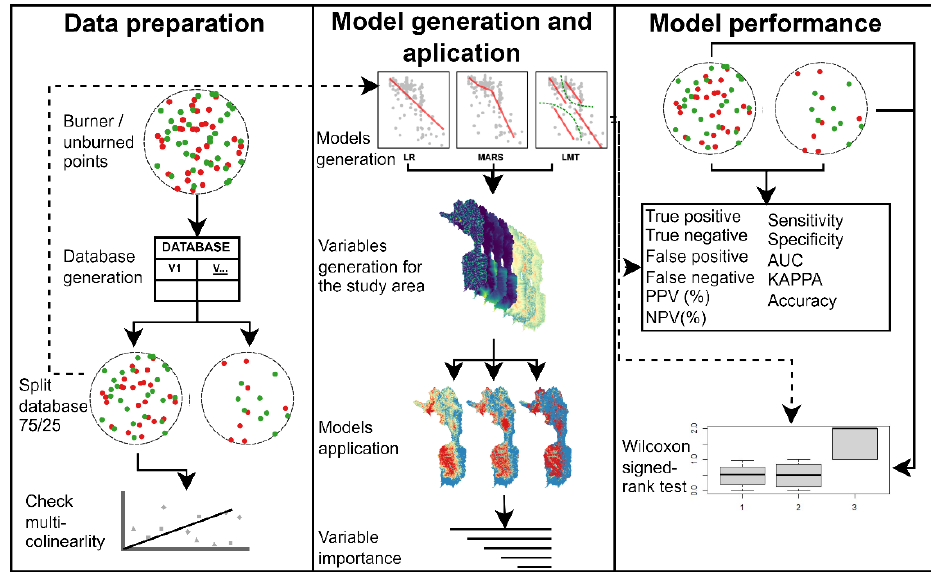
Figure 2. Detailed explanation of the experimental design.